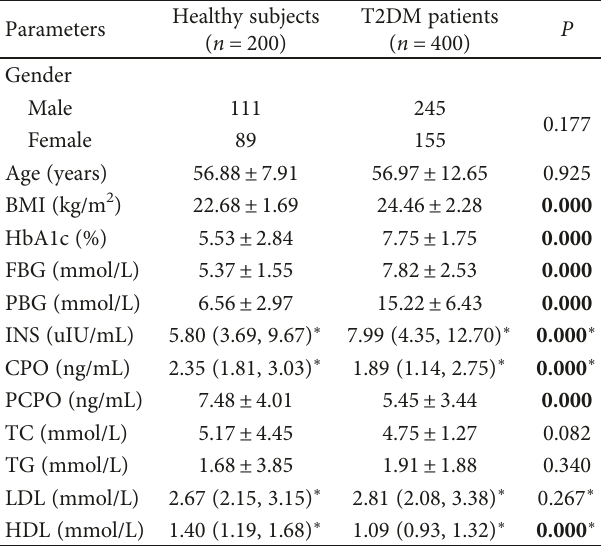
Table 1: Demographic and clinical characteristics of T2DM patients and healthy subjects.